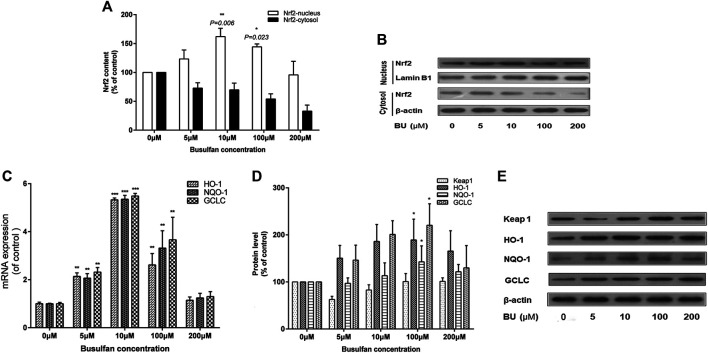
BU significantly activated Nrf2 signaling pathway. Nrf2 activation and its downstream proteins levels were gradually inhibited as the BU exposure increased significantly. Nrf2 protein levels (western blot analysis: A, B), HO-1, NQO-1, and GCLC mRNA levels (real time PCR analysis: C) and their protein levels (western blot analysis: D) in EA. hy 926 cells exposed to the increasing BU concentrations. * represents p < 0.05; ** represents p < 0.01; *** represents p < 0.001; μM represents μmol.